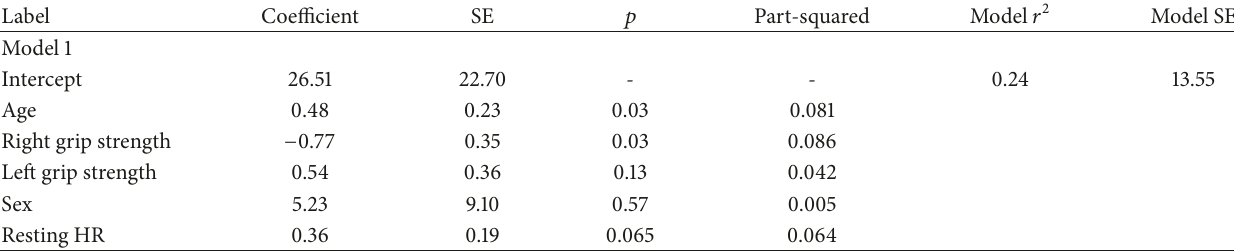
Table 4: Regression model for factors predicting hose drag completion times.